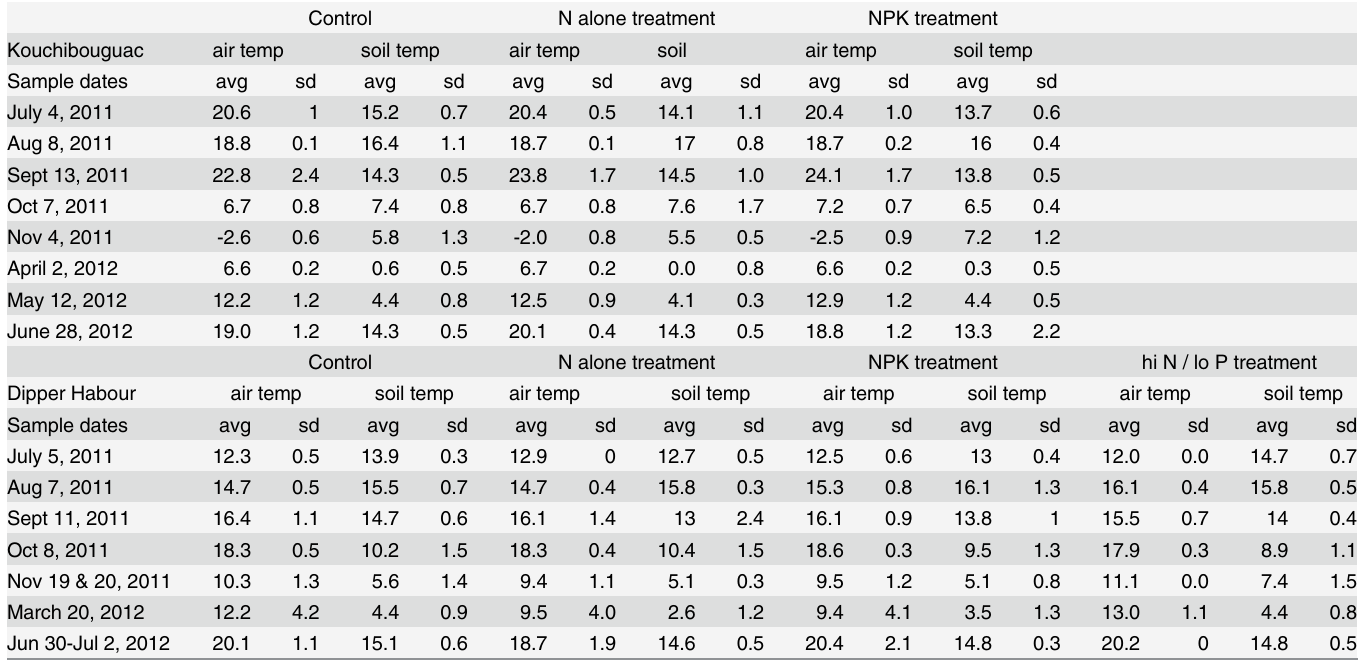
Table 1. Average (avg) and standard deviation (sd) of temperature (temp) measurements (°C) by treatment and sample event at Dipper Harbour and Kouchibouguac salt marshes. Control N alone treatment NPK treatment Kouchibouguac air temp soil temp air temp soil soil temp Sample dates